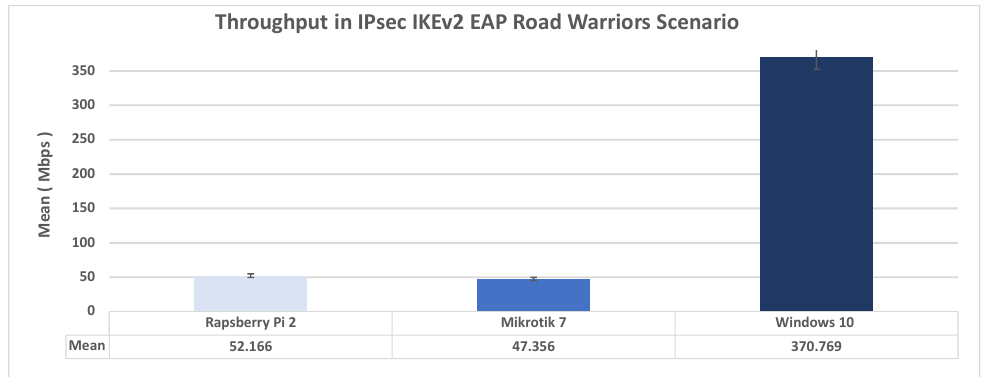
Figure 8. Comparison of the average Throughput in IKEv2-EAP Road Warriors